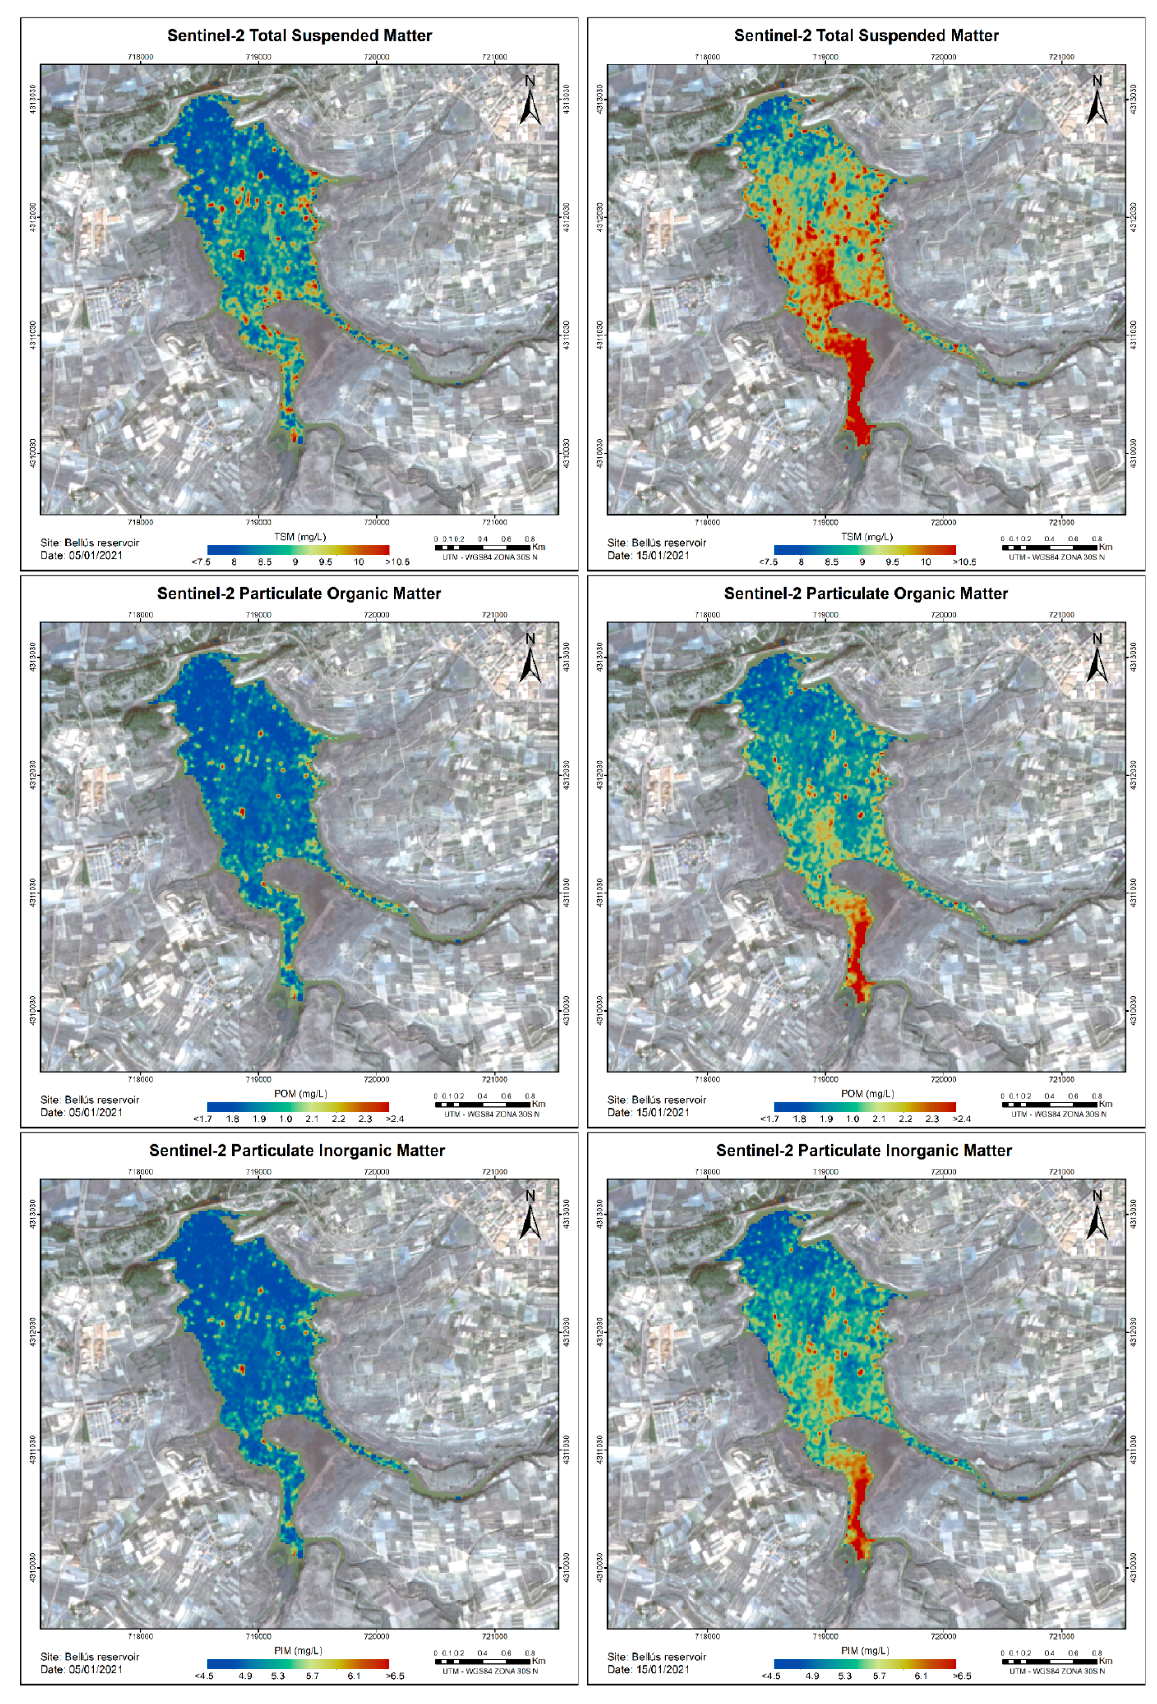
Figure 12. Bellús reservoir thematic maps for the three studied variables. Note different scales for POM and PIM.